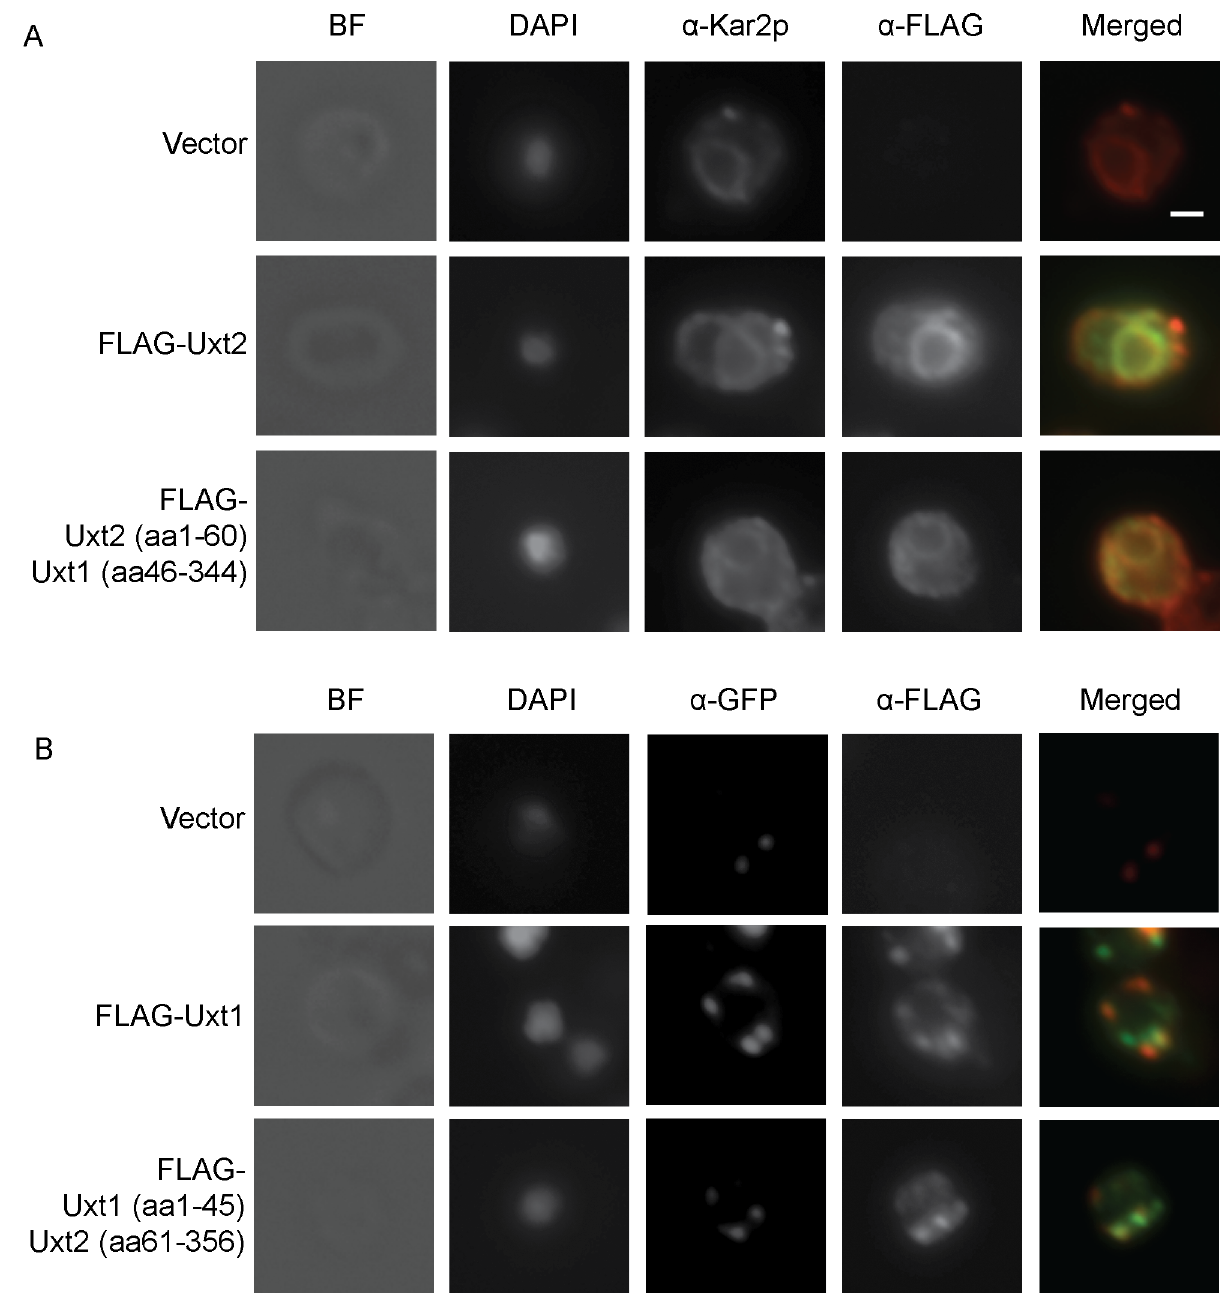
Fig 4. Subcellular localization of Uxt1 and Uxt2. Sec7-3xGFP S . cerevisiae cells transformed with vector alone (Vector) or vector expressingFLAG-tagged Uxt1, Uxt2, or chimeras of Uxt1 and Uxt2 were stained with DAPI and probedwith the indicatedantibodies. Bright field, singlechannel, and merged images are shown (scale bars, 1 μ m). Blue, DAPI; red, α -Kar2p/BiP to mark the ER (A) or α -GFP to localizethe Golgi marker Sec7 (B); green, α -FLAG. Images are representativeof three independentstudies. https://doi.org/10.1371/journal.ppat.1006765.g004 sparser network over the cell surface (Fig 5C, S5D Fig). The capsule changes were more strik- ing in uxt1 Δ uxt2 Δ cells; these showed significantly thinner capsules (S5A Fig) and reduced GXM shedding (S5C Fig). Their capsule fibers also appeared shorter and coarser than those of uxt1 Δ , resembling those of uxs1 Δ cells, which do not synthesize UDP-Xyl (Fig 5C, S5D Fig).